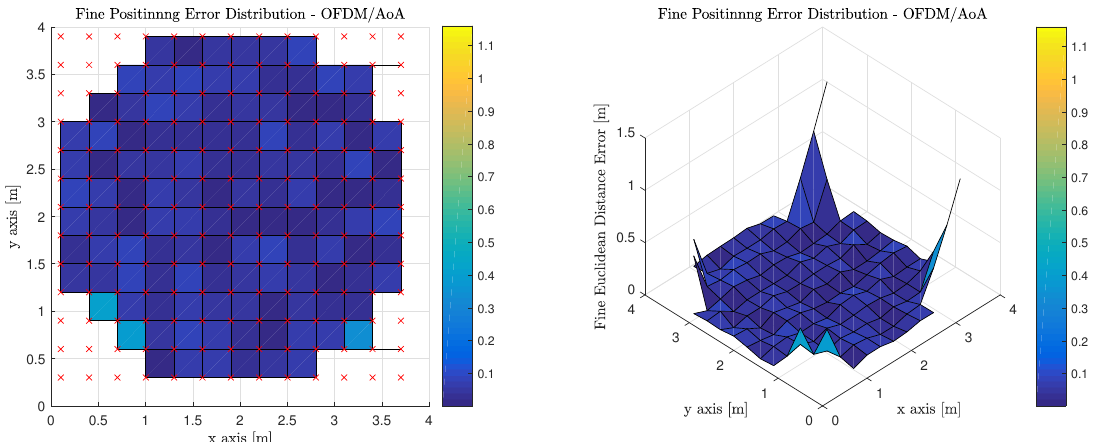
Figure 13. Fine Phase Positioning Performance in Candidate Room using Angle of Arrival Measurement, Geometric Constrained Optimized Triangulation Positioning Algorithm and Orthogonal Frequency Division Multiplexing.